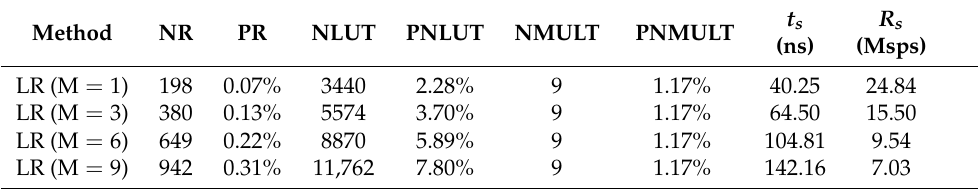
Table 2. Synthesis results regarding the hardware area occupation, processing time, and throughput for the linear regression (LR) prediction technique, NI = 1, and varying M from 1 to 9.